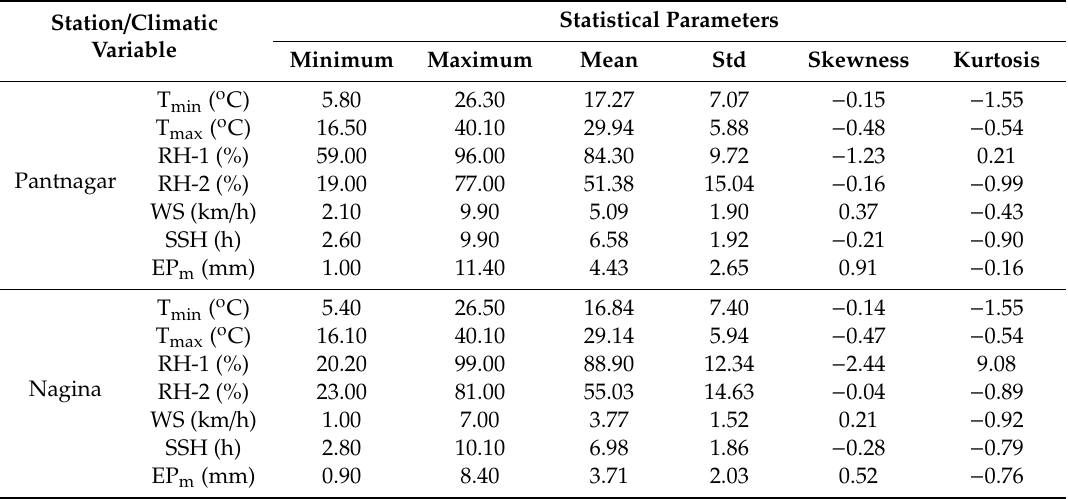
Note: std represents the standard deviation. Table 2. Inter-correlation between the climatic variables at the study stations. Station / Climatic